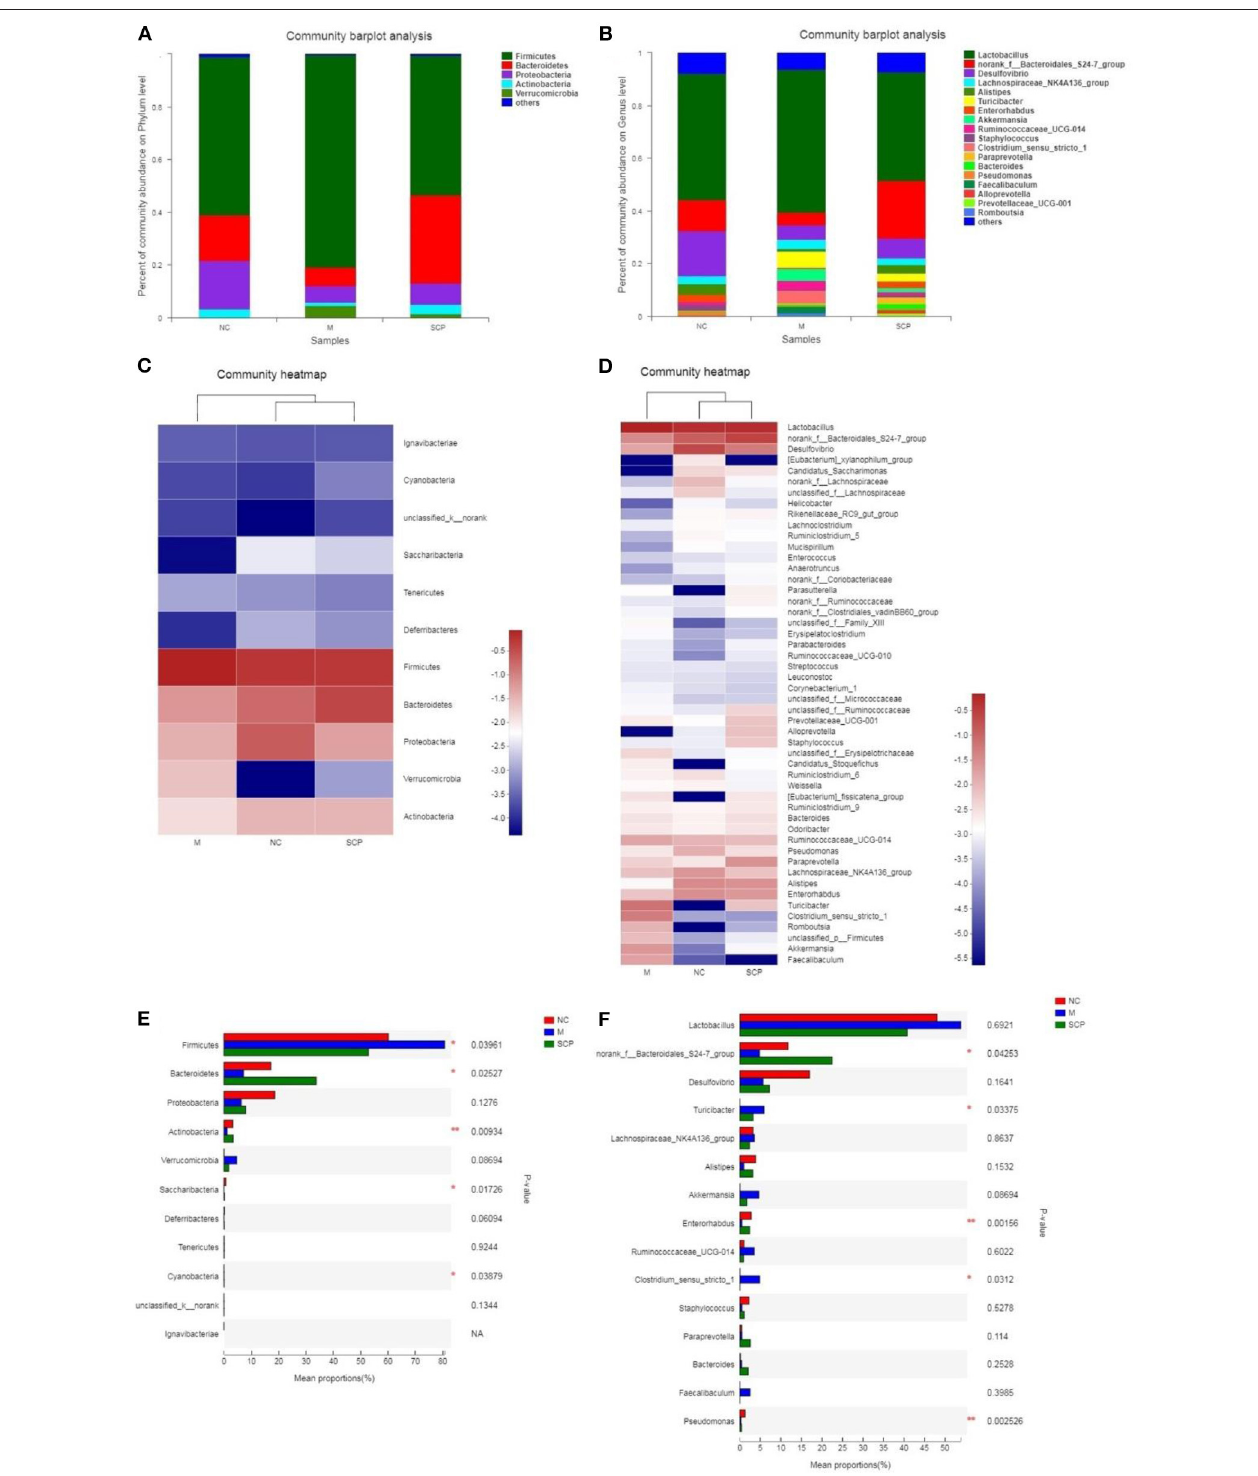
FIGURE 7 | Composition of the gut microbiota. (A) Phylum level. (B) Genus level. (C) Heat map analysis at phylum level. (D) Heat map analysis at genus level. (E) Main different composition at phylum level. (F) Main different composition at genus level. NC, control group; M, DSS group; SCP, S. chinensis polysaccharide group.